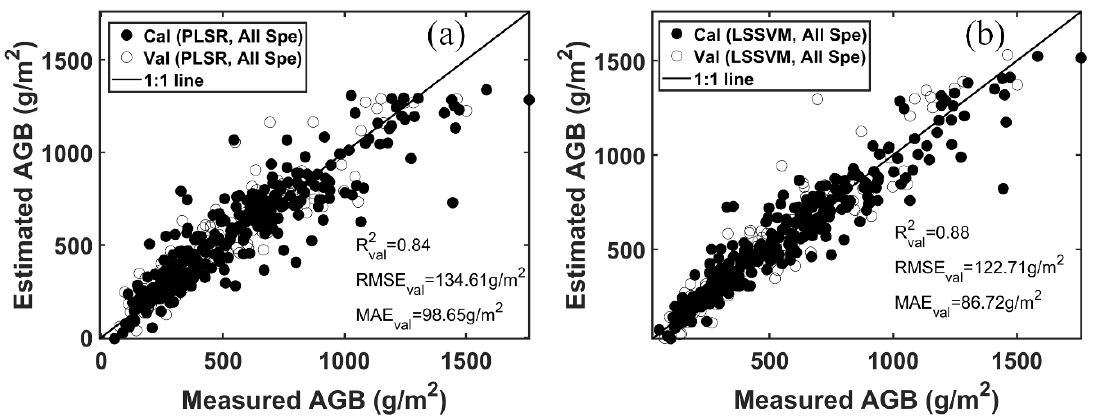
Figure A2. Predictive performance of the PLSR model ( a ) and LSSVM regression model ( b ) using all spectra (400 ⁓ 1350 nm) for winter wheat AGB estimation.